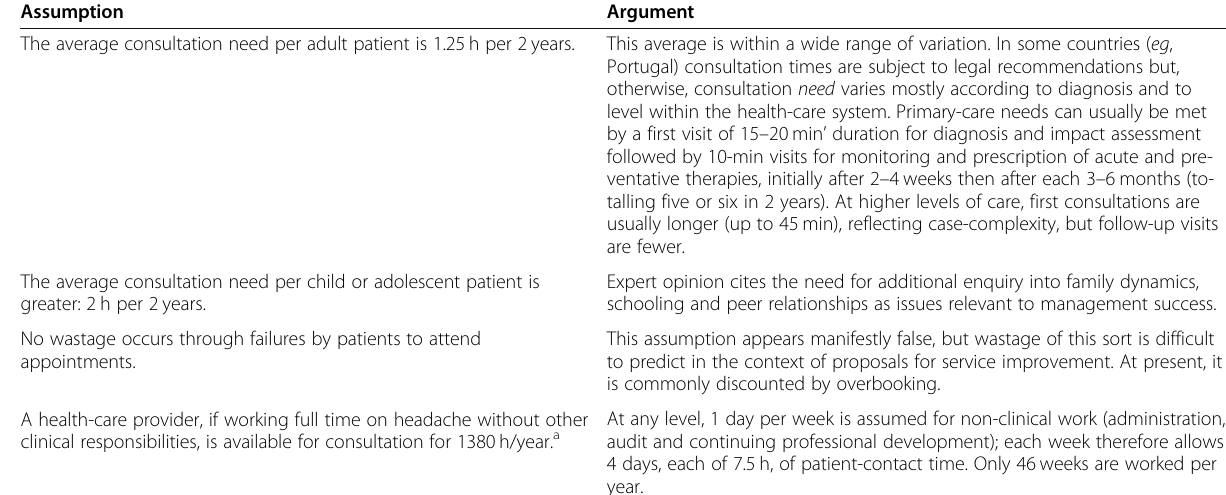
Table 1 Assumptions in estimating service requirements to meet headache-care demand in a population (updated and revised from